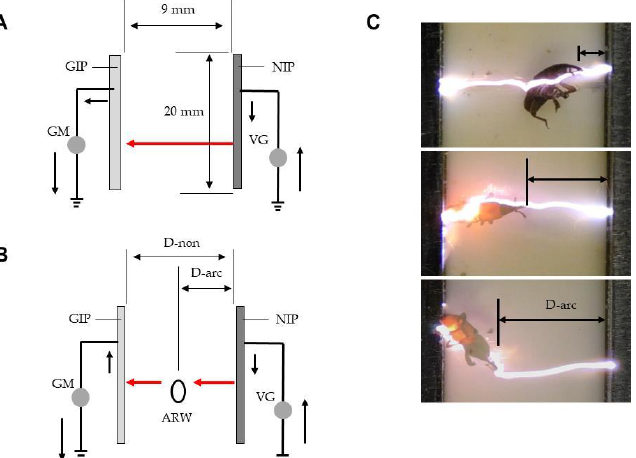
Figure 5. ( A ) Schematic representation of mechanical (arc) discharge between opposite poles (NIP and GIP). ( B ) Schematic representation of insect-mediated arcing between the poles of the ADE. ( C ) Rice weevils exposed to arcing at various distances from the NIP. The solid arrow represents the movement of electricity and the red arrow denotes the aerial movement of electricity via